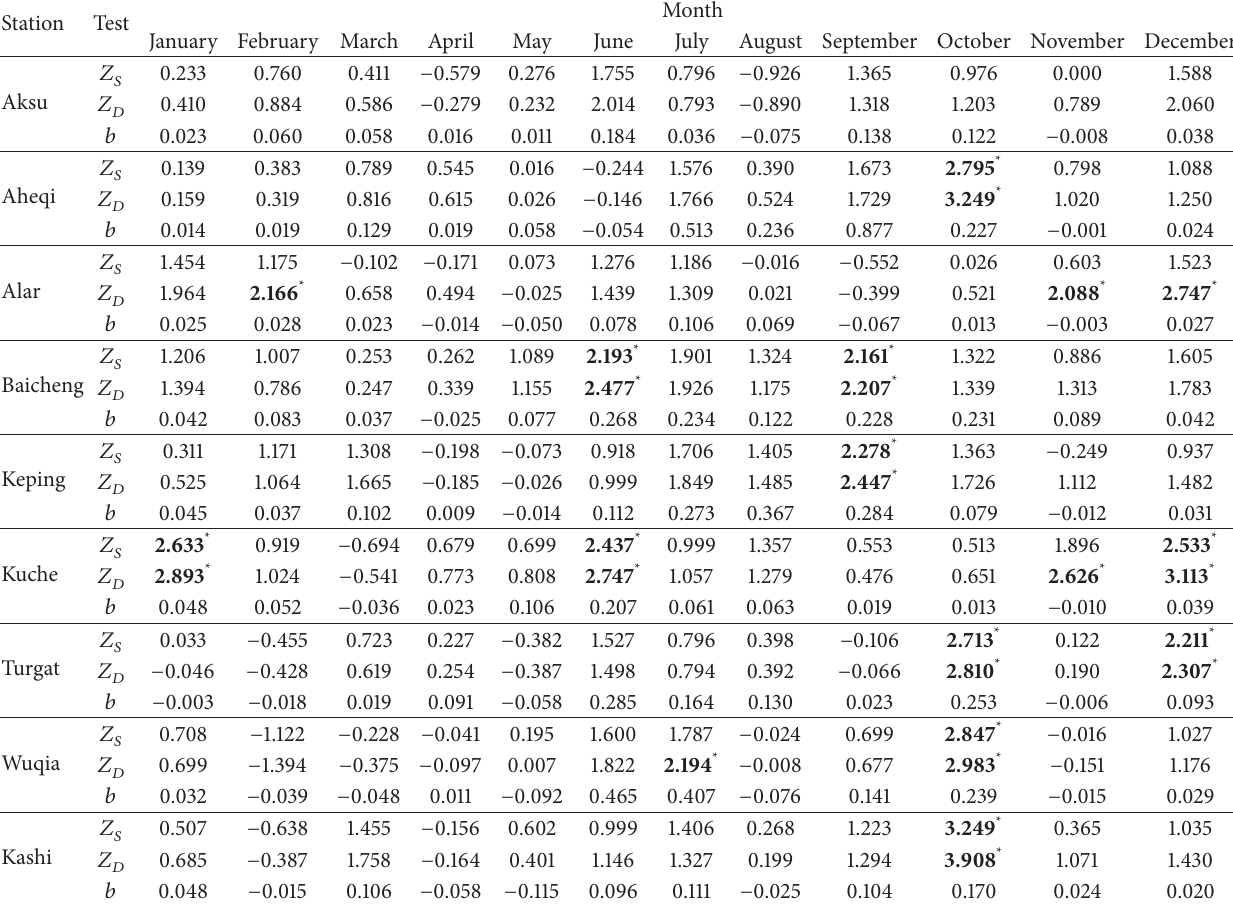
Table 6: Results of the statistical tests for the monthly precipitation during the period 1960–2010. Station